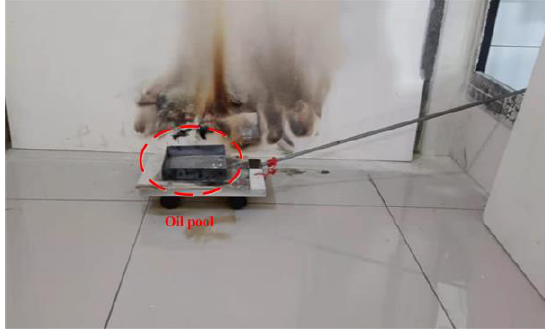
Figure 21. Mobile platform and oil pool.